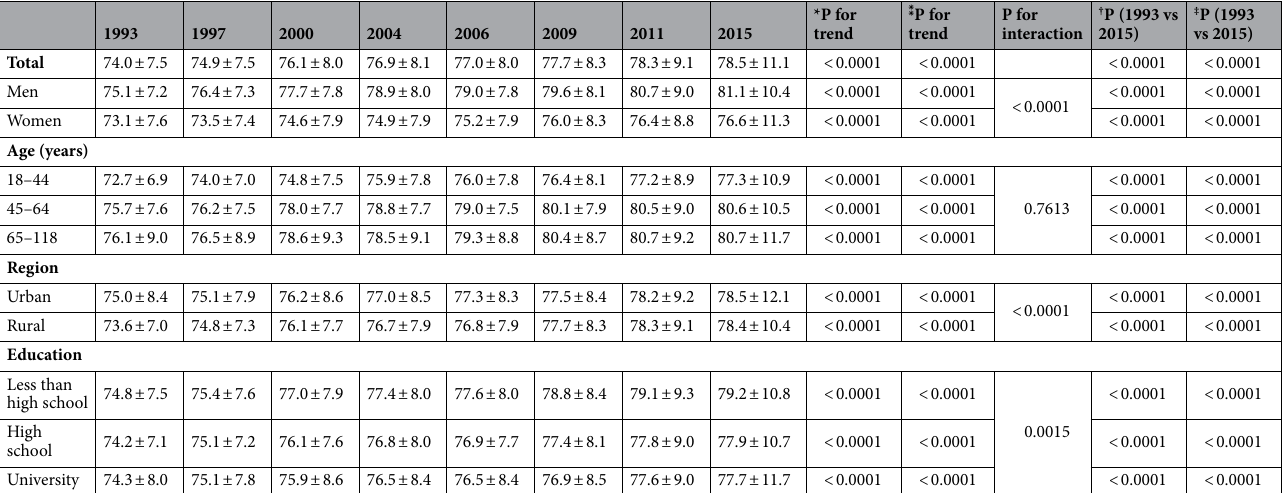
Table 1. Trends in age-standardized mean waist circumference among Chinese adults with body mass index < 25 kg/m 2 , 1993–2015. Mean WC were age-standardized to the age distribution of the China population in 2010. *P value for trend analysis. Linear regression model was used without any adjustment in the model. ⁑ P value for trend analysis in which age, sex, region, and educational attainment were adjusted in the linear models except when used as a stratified variable. † P value for comparison of 1993 and 2015. One-way ANOVA was used to compare differences. Applying the Bonferroni method for adjusting for multiple comparisons. There were 28 implied comparisons and an α = 0.0018 (α = 0.05/28) was used. ‡ P value for comparison of 1993 and 2015 after adjusting for age, sex, region, and educational attainment except when used as a stratified